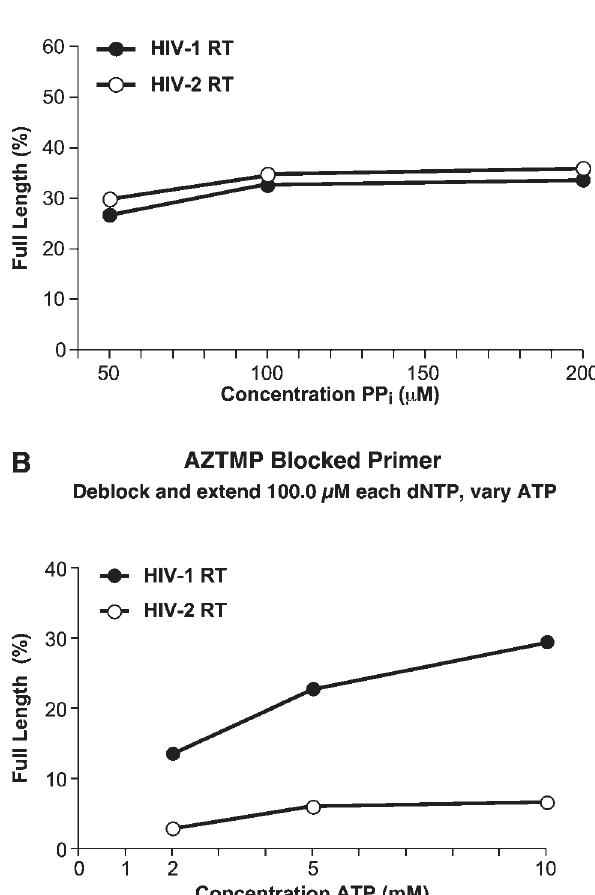
Table 1. Summary of the Single Nucleotide Incorporation Kinetics Assay